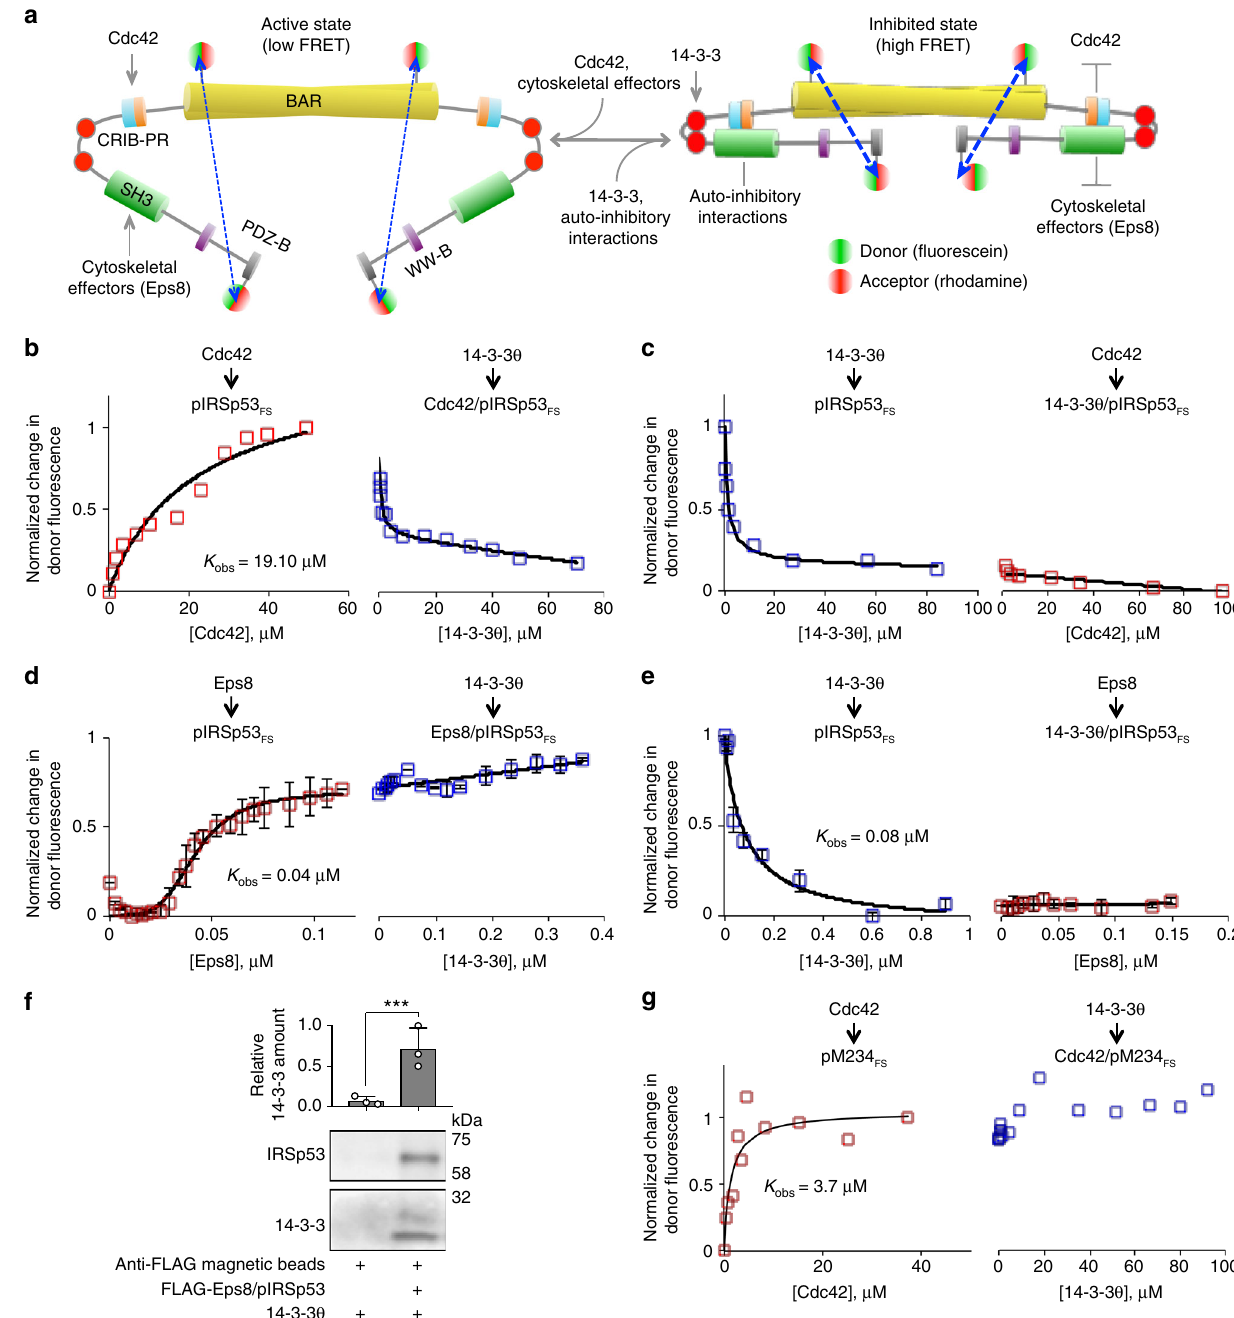
Fig. 5 A FRET-sensor assay shows inhibition of pIRSp53 by 14-3-3. a FRET sensor assay designed to report on conformational changes occurring in pIRSp53 as a function of interactions with binding partners. Phosphorylated IRSp53 (mutant S519C) was expressed and puri fi ed as shown in Fig. 1 and labeled at C230 (within the BAR domain) and C519 (near the C-terminus) with the donor/acceptor pair fl uorescein/rhodamine (pIRSp53 FS ). The same batch of probes and donor/acceptor ratio were used in all labeling reactions. Conformational changes in pIRSp53 FS are detected based on the amount of FRET between the fl uorescence probes at these two distant positions. b , c FRET titration of 2 μ M GNPPNP-Cdc42 (G12V mutant) into 0.2 μ M pIRSp53 FS (red squares), followed by the titration of 0.2 μ M 14-3-3 θ (blue squares) and reverse-order titration. d , e FRET titration of 0.2 μ M Eps8 into 0.05 μ M pIRSp53 FS (red squares), followed by the titration of 4 μ M 14-3-3 θ (blue squares) and reverse-order titrations. Pairs of titrations were normalized to the total change in FRET. Each titration was fi t to a non-cooperative binding function (black lines), except that of Eps8 into pIRSp53 FS , which was fi t to a cooperative binding function with non-speci fi c binding (see Methods). f Relative abundance of 14-3-3 pulling down with anti-Flag magnetic beads in the presence or the absence of the FLAG-Eps8/pIRSp53 complex. Error bars are ± s.d. from three independent experiments, shown as open circles. The statistical signi fi cance of the measurements was determined using an unpaired two-sided Student ’ s t -test (*** p < 0.001). g FRET titration of 2 μ M GNPPNP-Cdc42 into 0.2 μ M mutant M234 FS (red squares), followed by the titration of 0.2 μ M 14-3-3 θ (blue